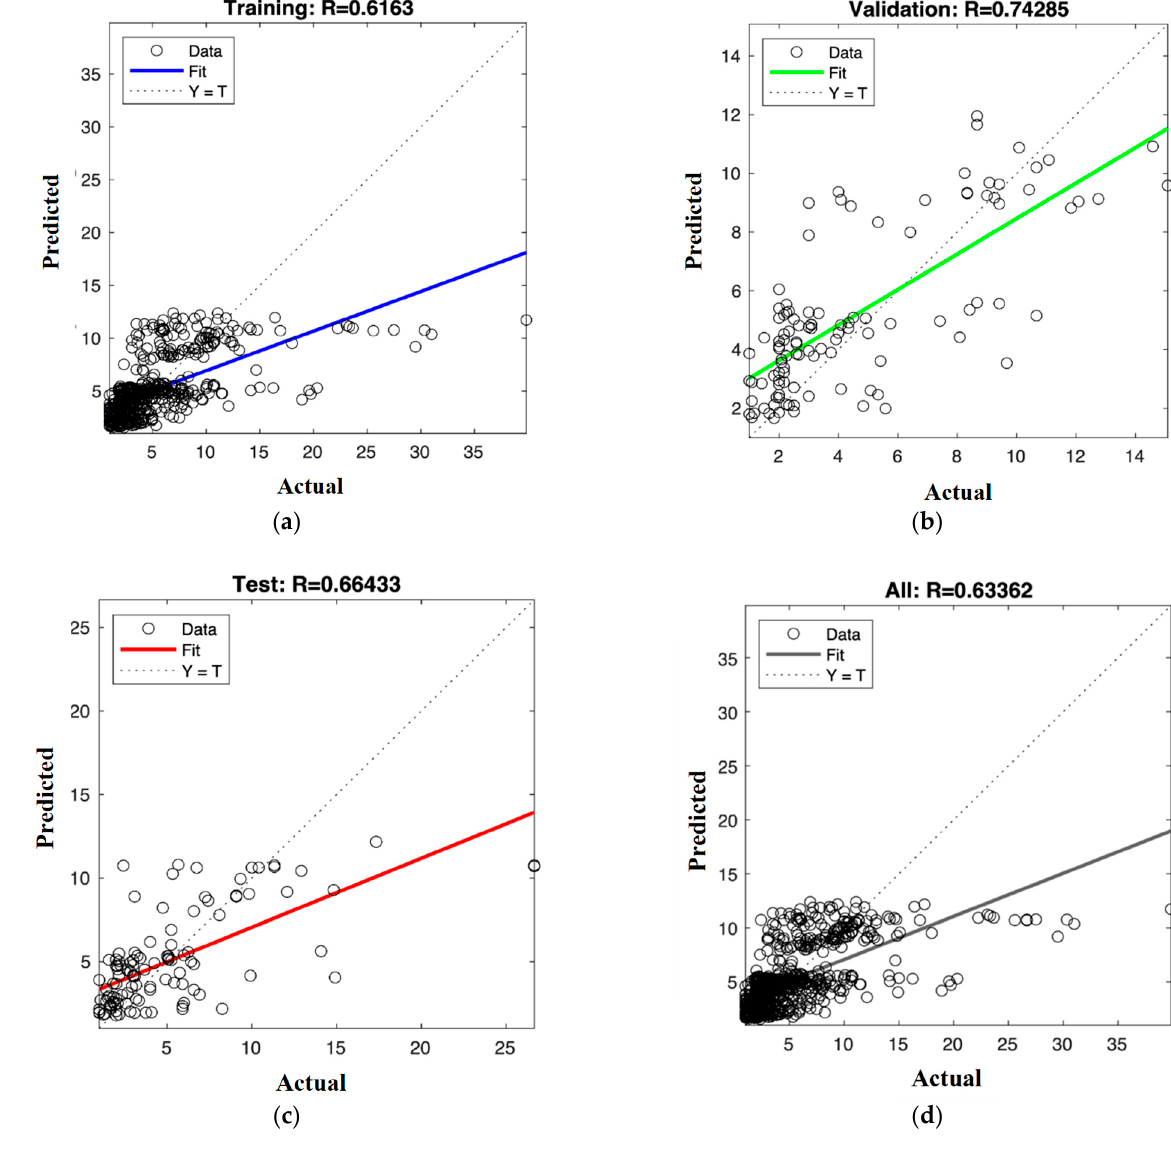
Figure 5. Predicted vs. Actual particulate matter quantity for ANN model for: ( a ) training; ( b ) validation; ( c ) test; and ( d ) all data.